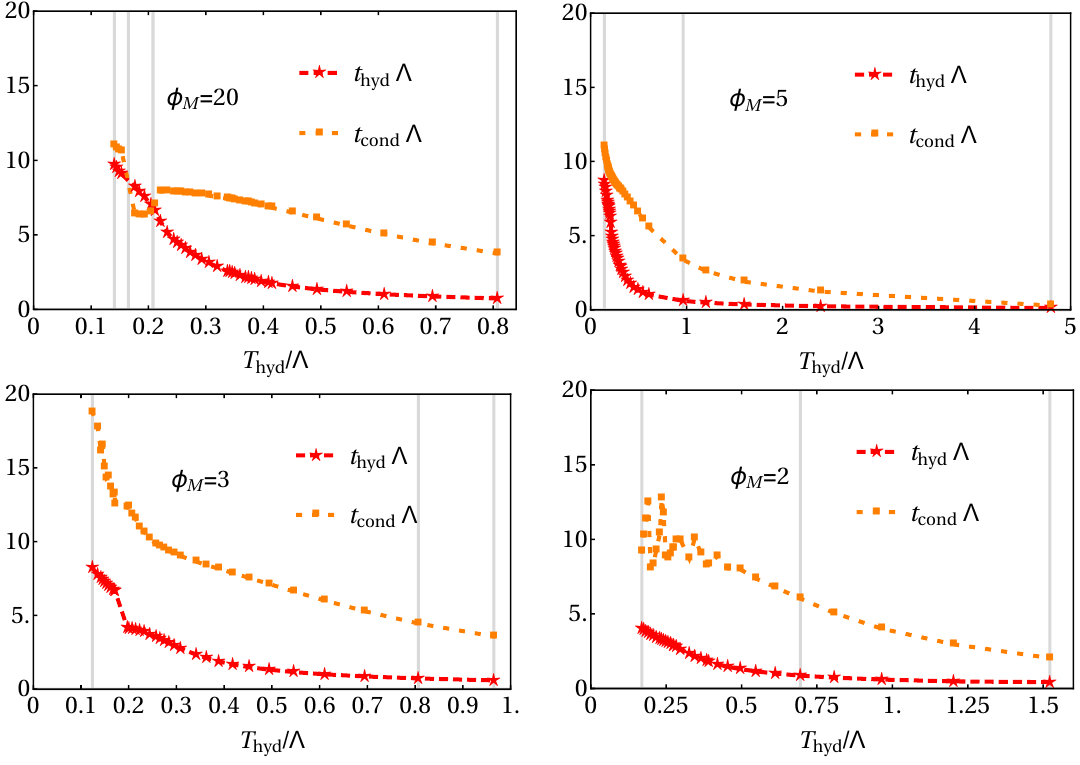
Figure 12 . Condensate relaxation times and hydrodynamization times for collisions with (cid:22)! = 0 : 30 in models with (cid:30) = f 20 ; 5 ; 3 ; 2 g . The leftmost (rightmost) grey vertical line indicates the lowest M (highest) temperature that we probed. The other grey vertical lines indicate either points at which t cond = t hyd or points at which the ratio t cond =t hyd is maximal. The positions of these lines in each panel is as follows. Top left: T hyd = (cid:3) = f 0 : 141 ; 0 : 165 ; 0 : 208 ; 0 : 807 g . The highest temperature in this case is the one at which the ratio t cond =t hyd is maximal. Top right: T hyd = (cid:3) = f 0 : 143 ; 0 : 964 ; 4 : 80 g . Bottom left: T hyd = (cid:3) = f 0 : 124 ; 0 : 807 ; 0 : 965 g . Bottom right: T hyd = (cid:3) = f 0 : 169 ; 0 : 695 ; 1 : 52 g